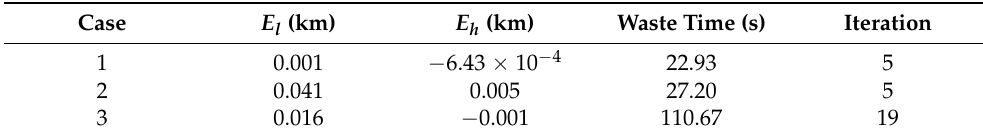
Table 1. Generation effect with different cases.